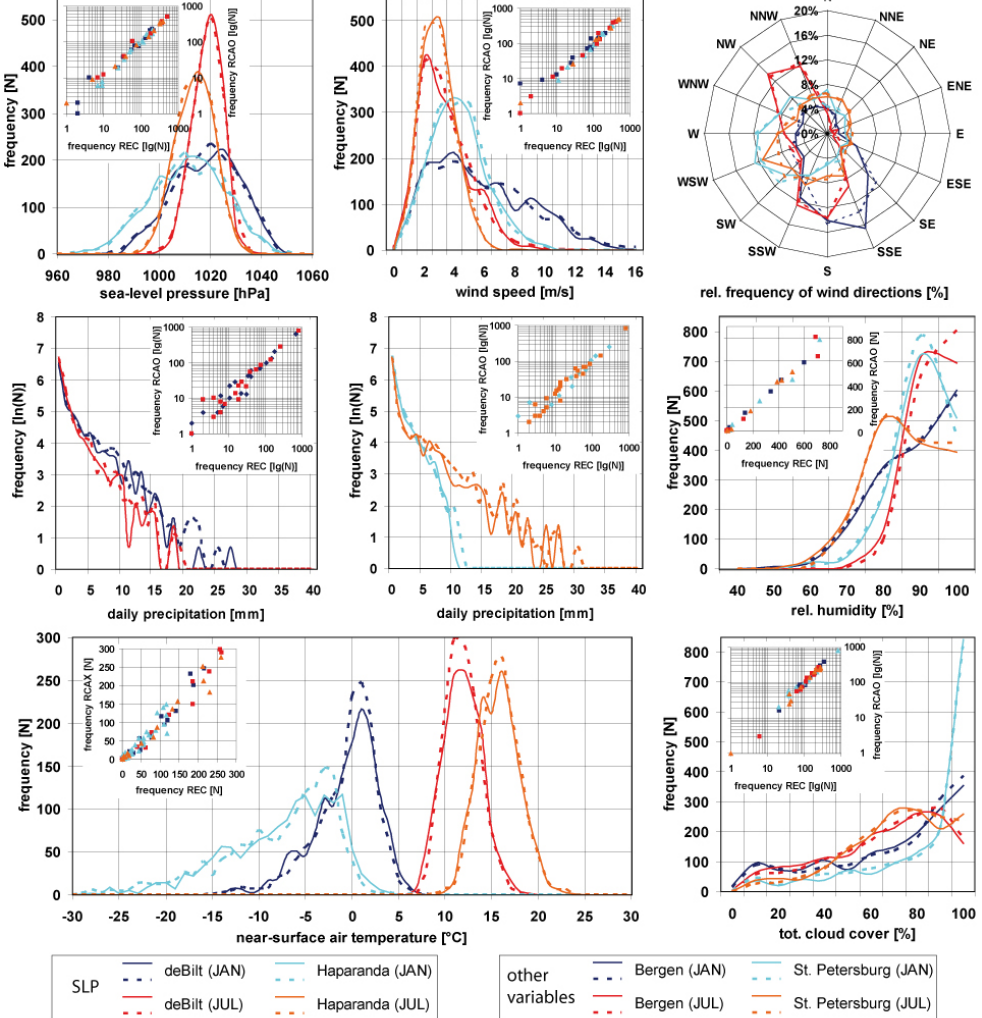
Fig. 9. Comparison of the frequency distributions between reconstruction (HiResAFF, solid lines) and reference fields from RCAO (RCAX for T2M) (shaded lines) for different variables for January and July. Grid points are chosen in the vicinity of de Bilt and Happaranda in thr SLP case to highlight latitudinal changes. For other variables, Bergen and Saint Petersburg are chosen to depict differences between more maritime-advective (Bergen) and continental (Saint Petersburg) climate regimes. Embedded are the scatter plots of the regression between the reconstructed and simulated distributions. Note different usage of scaling (log, and